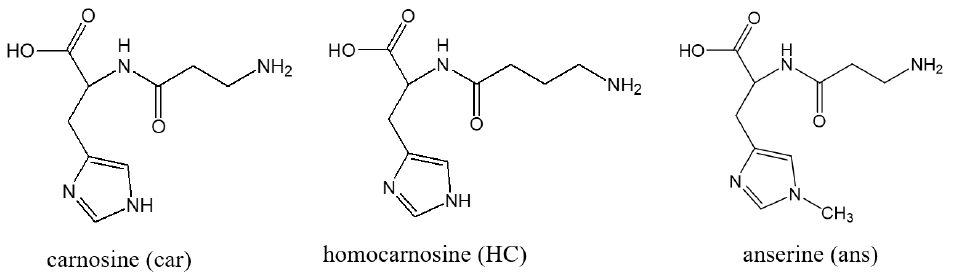
Figure 3. Structures of carnosine and its analogues. Chemical structures of carnosine (Car), anserine (Ans), and homocarnosine (HC) are